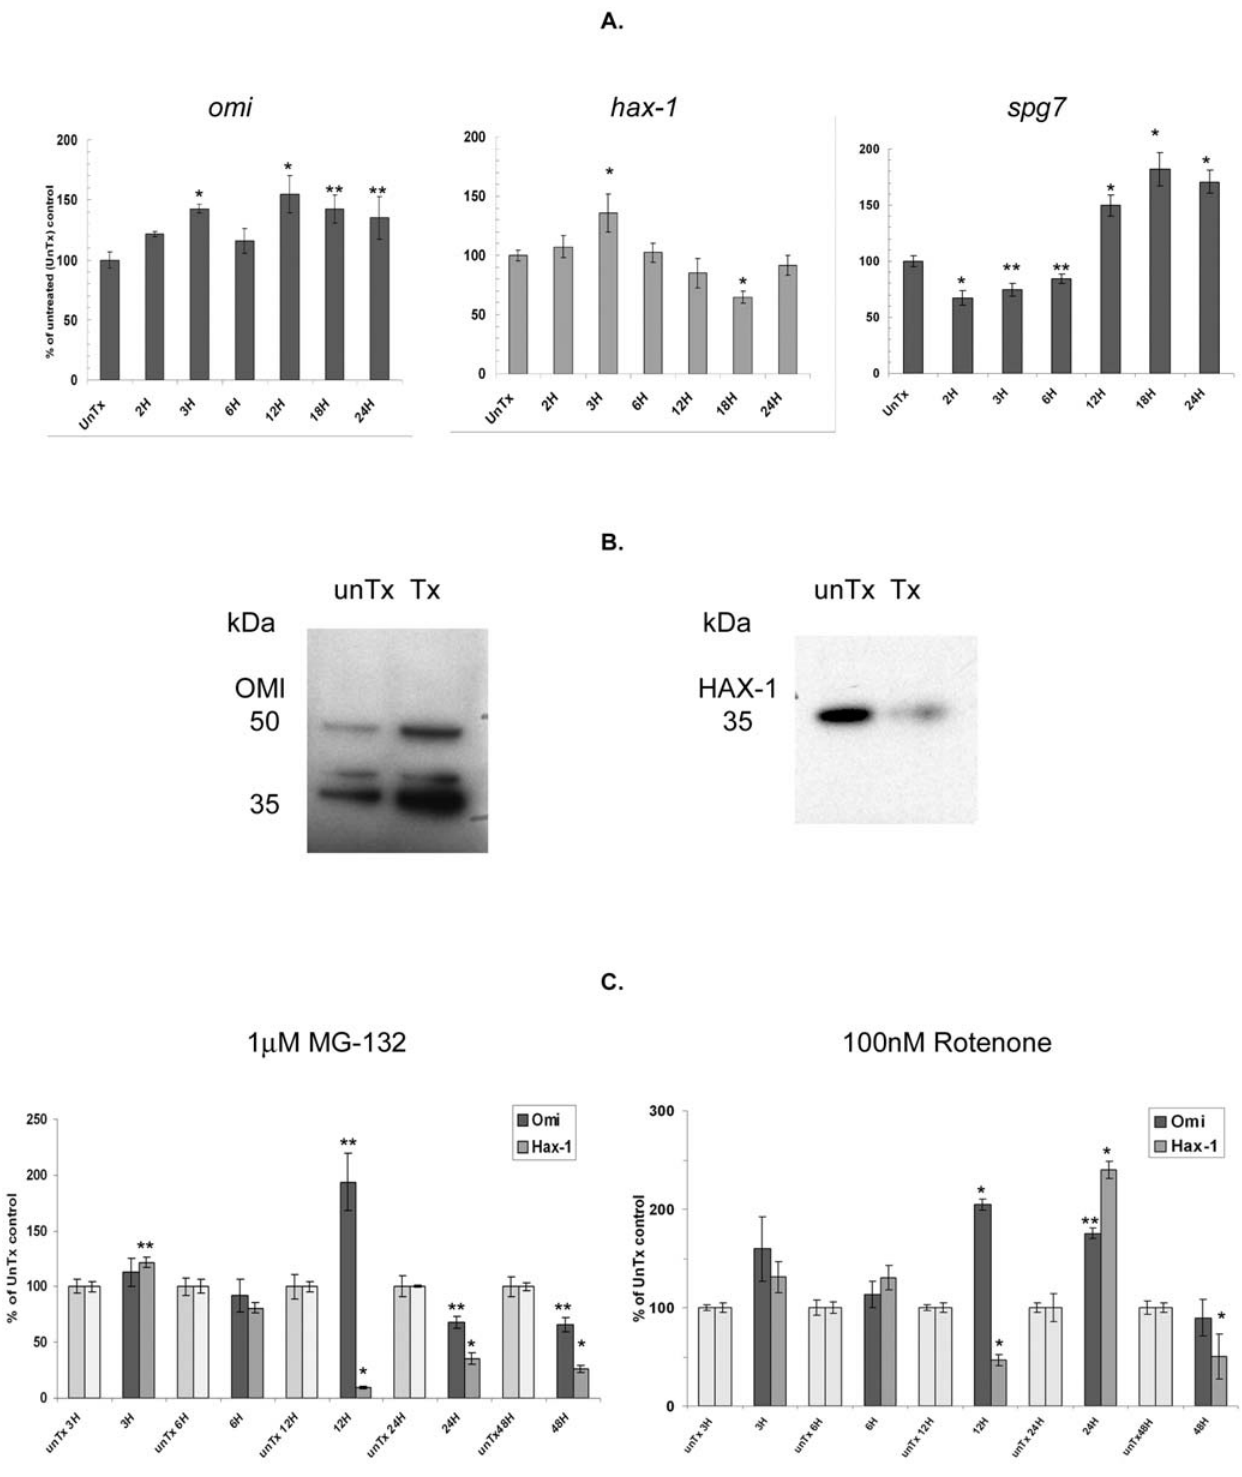
Figure 4. Gene expression studies of omi , hax -1 and spg 7 (paraplegin) in SH-SY5Y cells treated with 100 m M 6OHDA (A). Expression is normalized for b -actin and shown as a percentage of the untreated control (UnTx). (B) Representative immunoblots showing the level of OMI and HAX-1 in untreated and 6OHDA-treated SH-SY5Y cells. (C) Gene expression studies of omi and hax- 1 in SH-SY5Y cells treated with the proteasome inhibitor MG132 (1 m M) or Complex I inhibitor Rotenone (100 nM). Expression is shown as a percentage of the untreated control (UnTx) where all data is the Mean 6 SEM: n $ 3, and where * indicates P # 0.005 and ** indicates P # 0.05 (using two tailed t-test analysis).